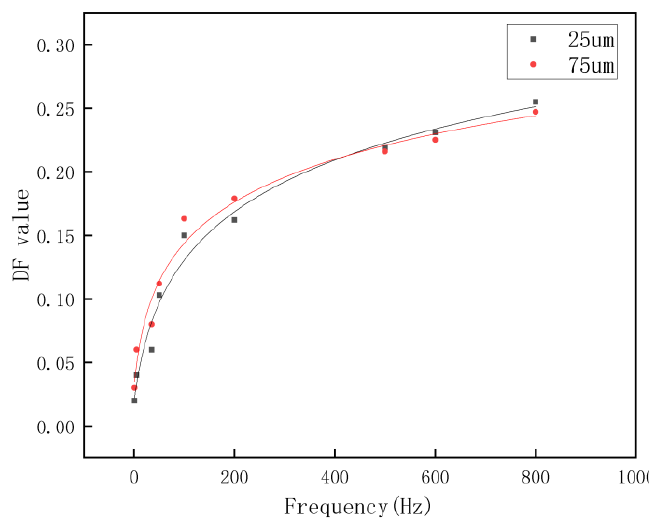
Figure 7. E ff ect of vibration frequency on particle distribution in vibration. Figure 7. Effect of vibration frequency on particle distribution in